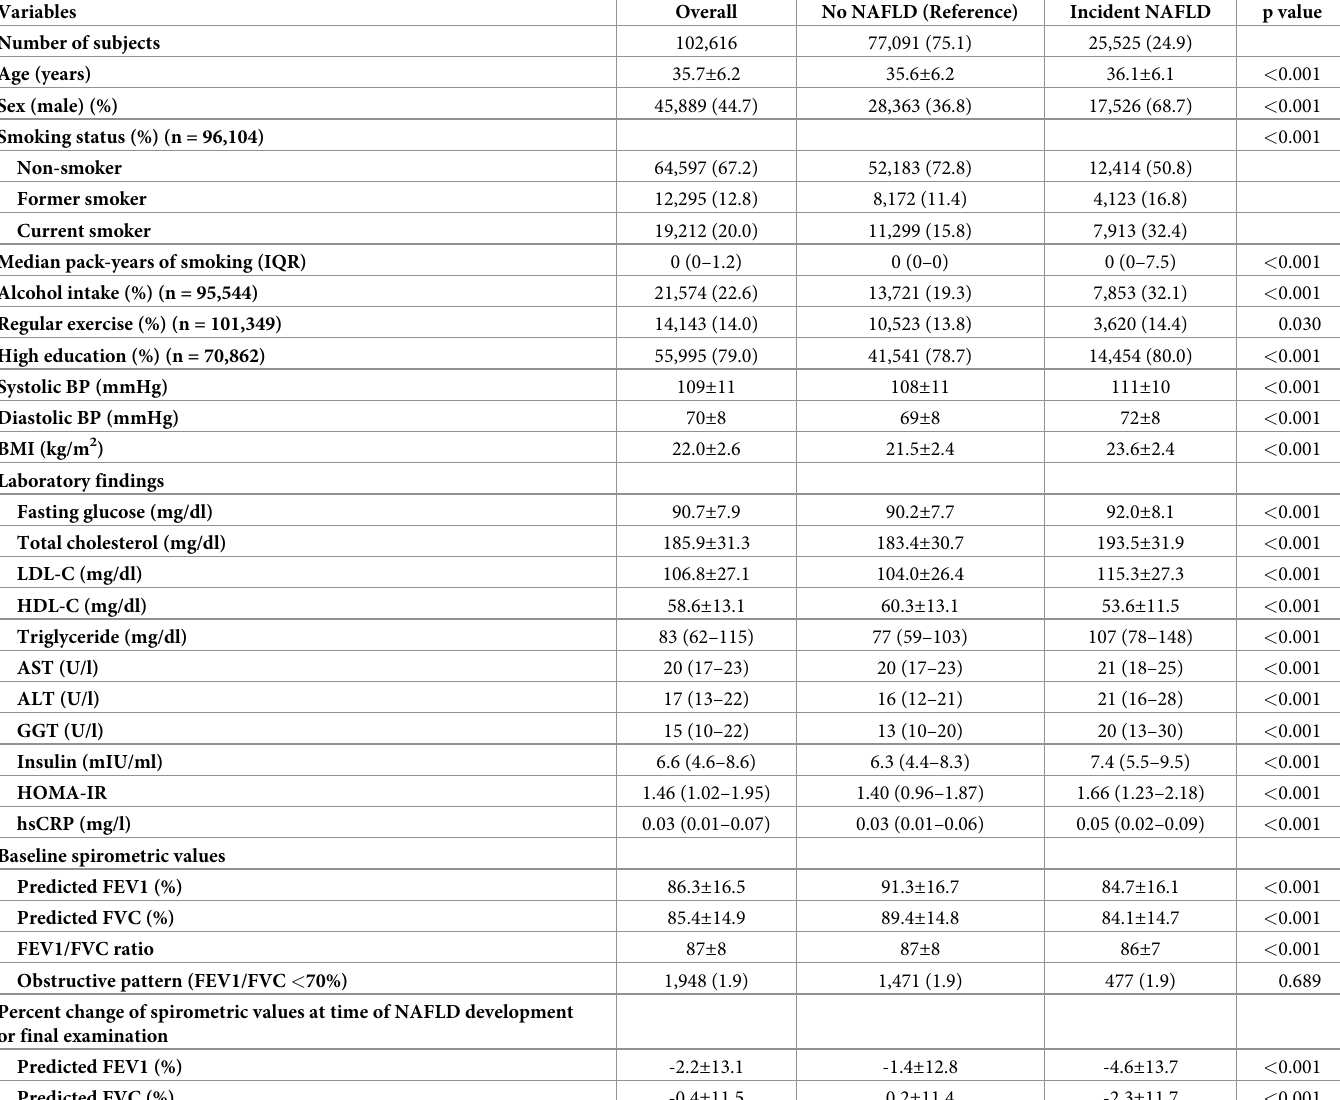
Table 1. Baseline characteristics according to the change in fatty liver status over the follow-up